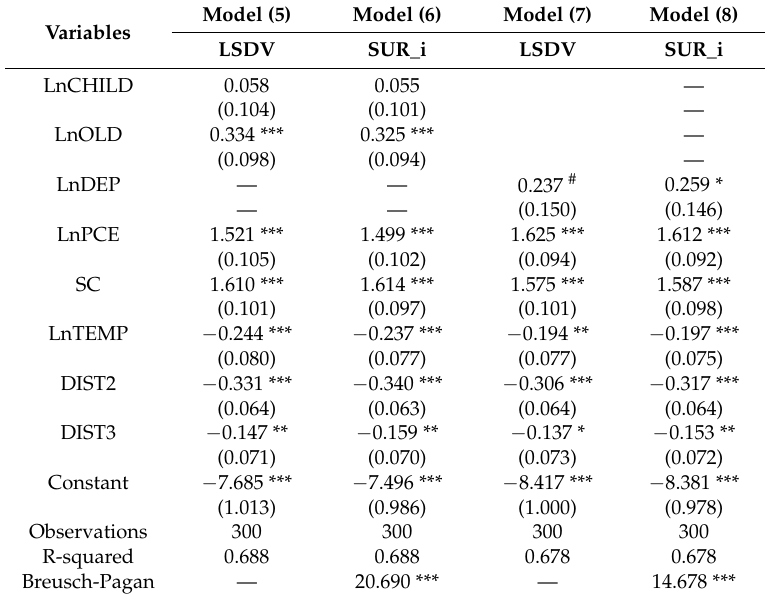
Table 4. Determinants of rural residential energy consumption per capita